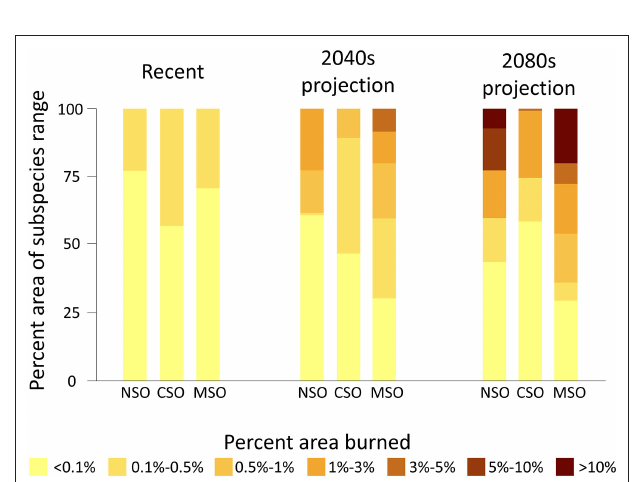
FIGURE 4 | Recent and projected percent of range burned by spotted owl subspecies and by 7% area burned classes. NSO, Northern spotted owl; CSO, California spotted owl; MSO, Mexican spotted